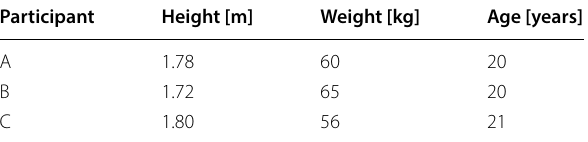
Table 1 Anthropometric data Participant